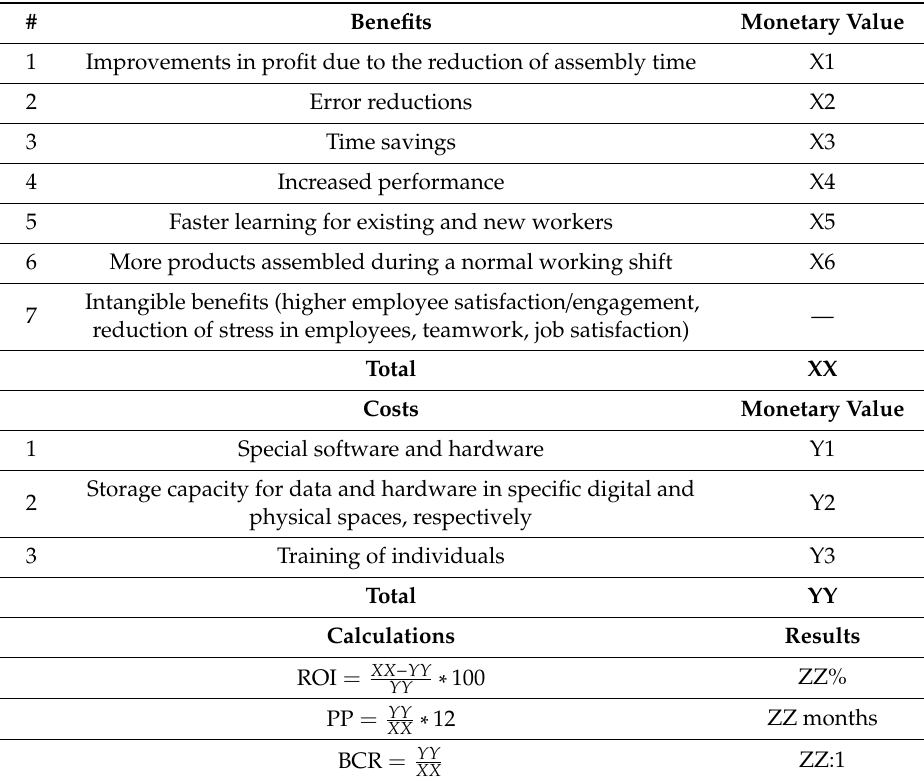
Table 3. Identification of project